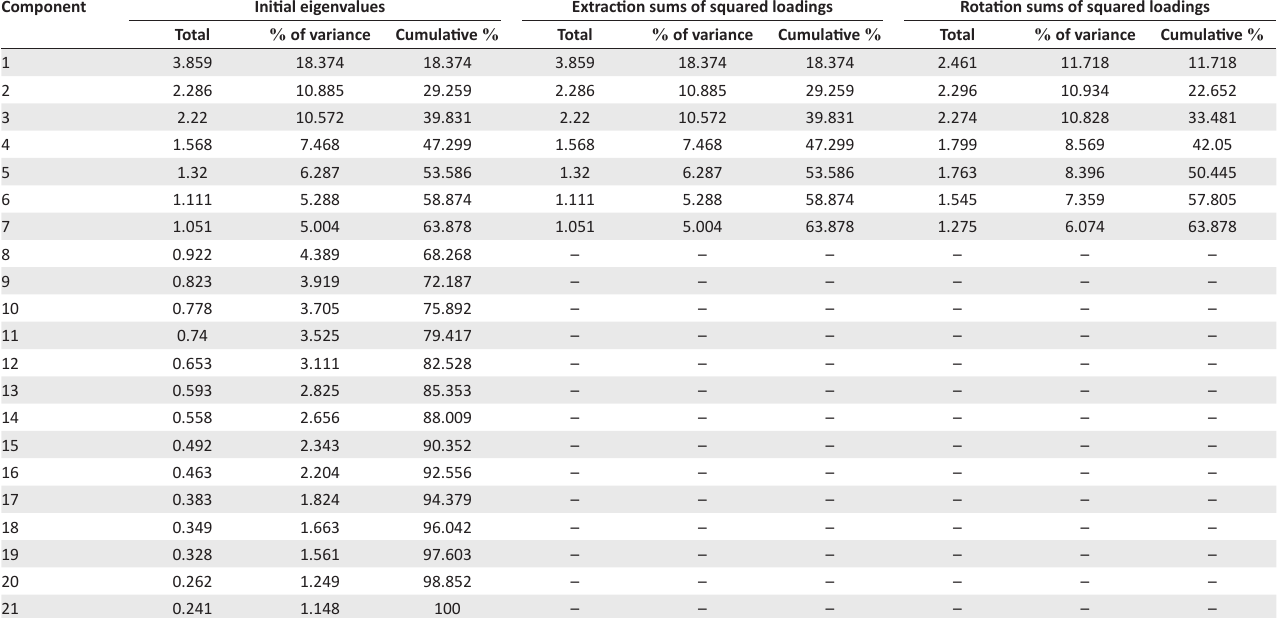
TABLE 1: Exploratory factor analysis total variance explained.